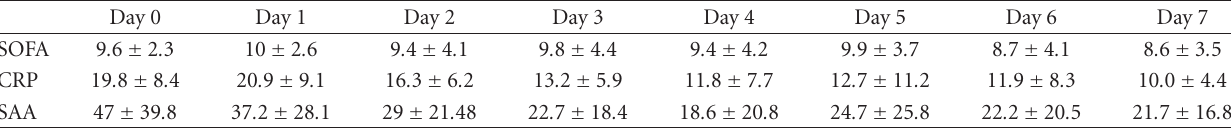
Table 3: SOFA, CRP, and SAA during the study period (mean ±